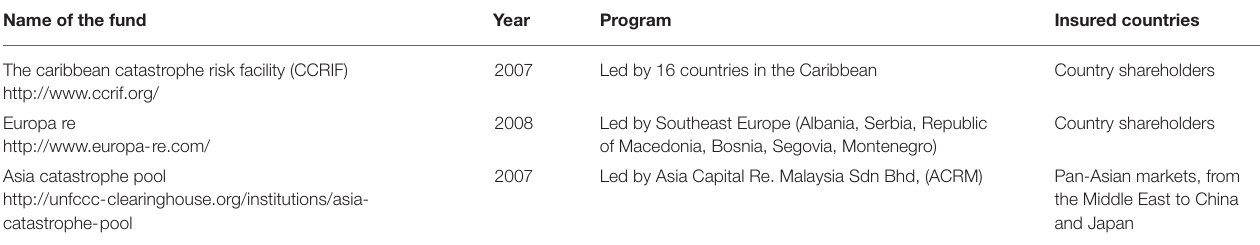
TABLE 3 | Regional risk pooling mechanisms for managing catastrophic